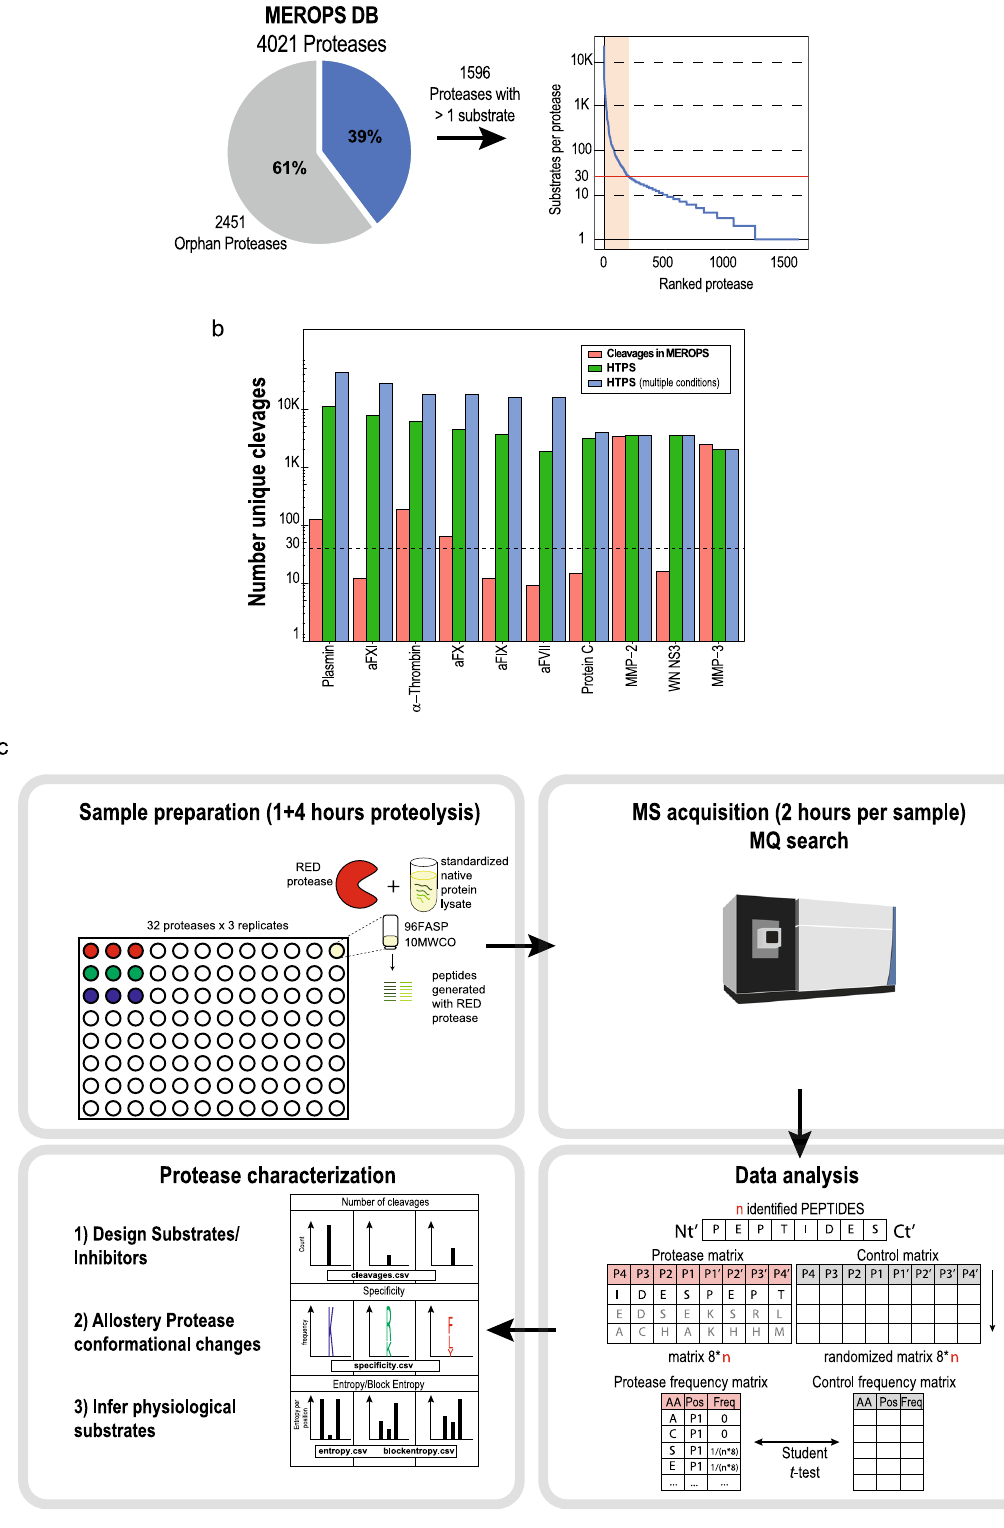
the external standard iRT peptides that were used to check the (Supplementary Fig. 1a, b). The result of these steps are sets of fragment ion spectra of peptides that are highly enriched for substrates of the protease